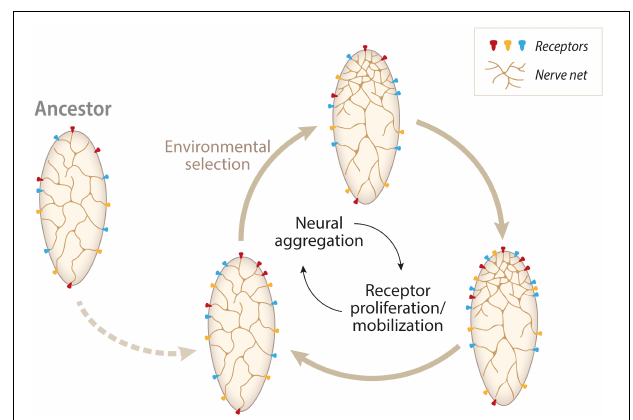
FIGURE 1 | A diagram representing one scenario for the evolution of centralized nervous systems from nerve-net precursors. The driving force is assumed to be a feedback loop between the number and diversity of receptors (sensory) and the neural aggregation in their vicinity. We called the hypothesis, the “Receptor and Neuronal Aggregation (RNA) Hypothesis.” In summary, the hypothesis assumes an ancestor with few dispersed receptors in the body. The subsequent movement from an isotropic (benthic zone) to an anisotropic environment (the pelagic zone) would have selected the concentration of receptors at one specific location in the body (the head primordium). The presence of receptors will drag the neurons to the same body area, with the saving wire (neural processes length) as an energetic bonus. These aggregations of neurons would, eventually, interconnect, providing with a higher computing capacity to the ensemble. The whole process would gain by repeating itself many times, with more receptors accruing in the vicinity of the concentrated neural network followed by another round of neuronal mobilization or duplication/proliferation. These recurrent processes would be able to generate many, concentrated, neural architectures (brains). Adapted from Martinez et al.